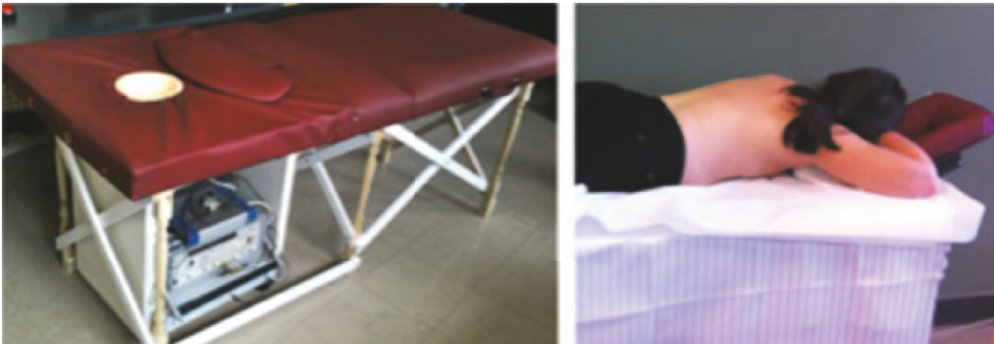
Figure 27: Photos of clinical prototype with test table and scanning patient at McGill University [30]. Image copyright IEEE, used with